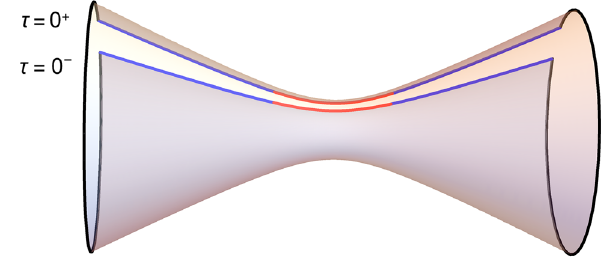
Fig. 12 Representation of the complex-extended geometry that con- nects the boundary τ = 0 − , with the boundary τ = 0